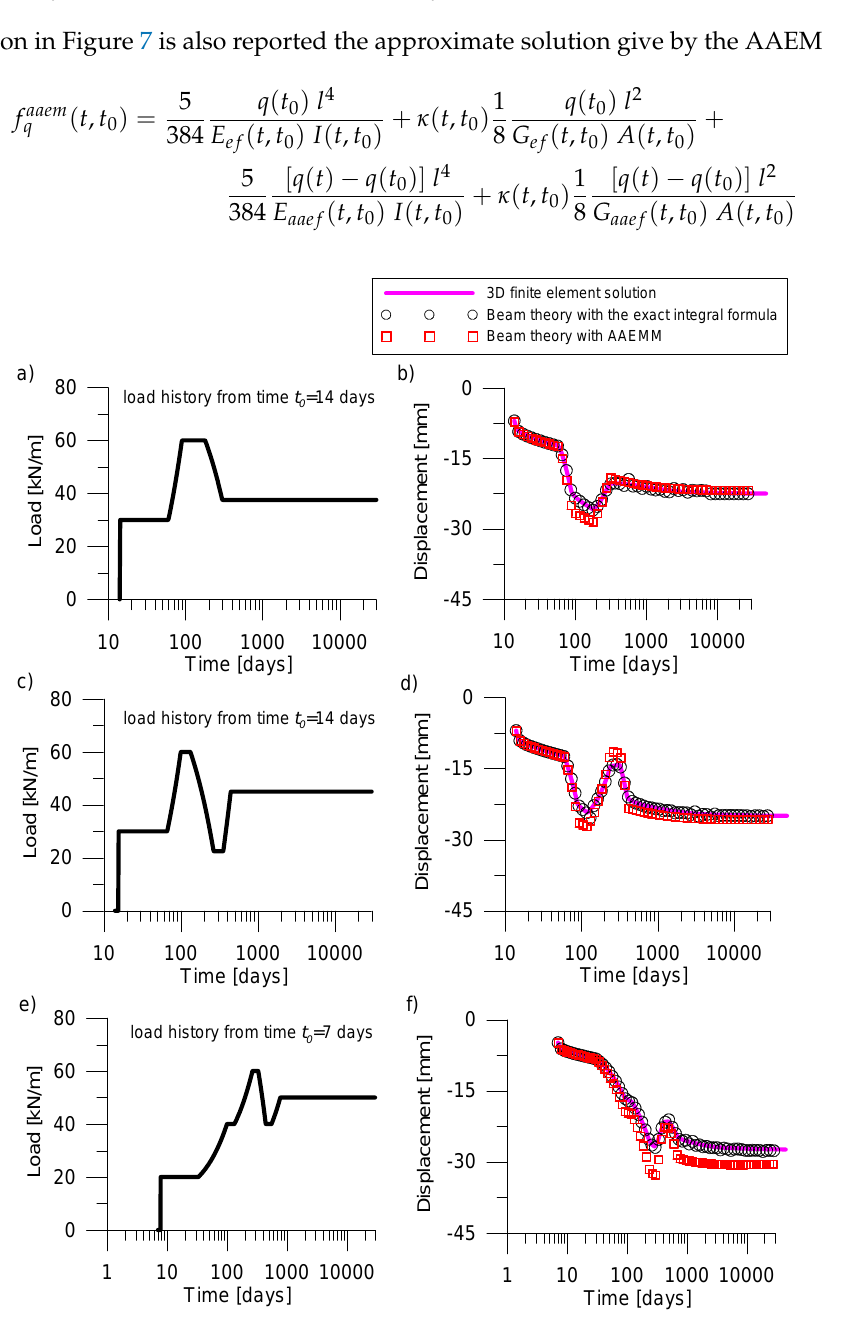
Figure 7. Simply supported prestress beam under different load histories ( a , c , e ), on the left, and, on the right the corresponding deflections ( b , d , f